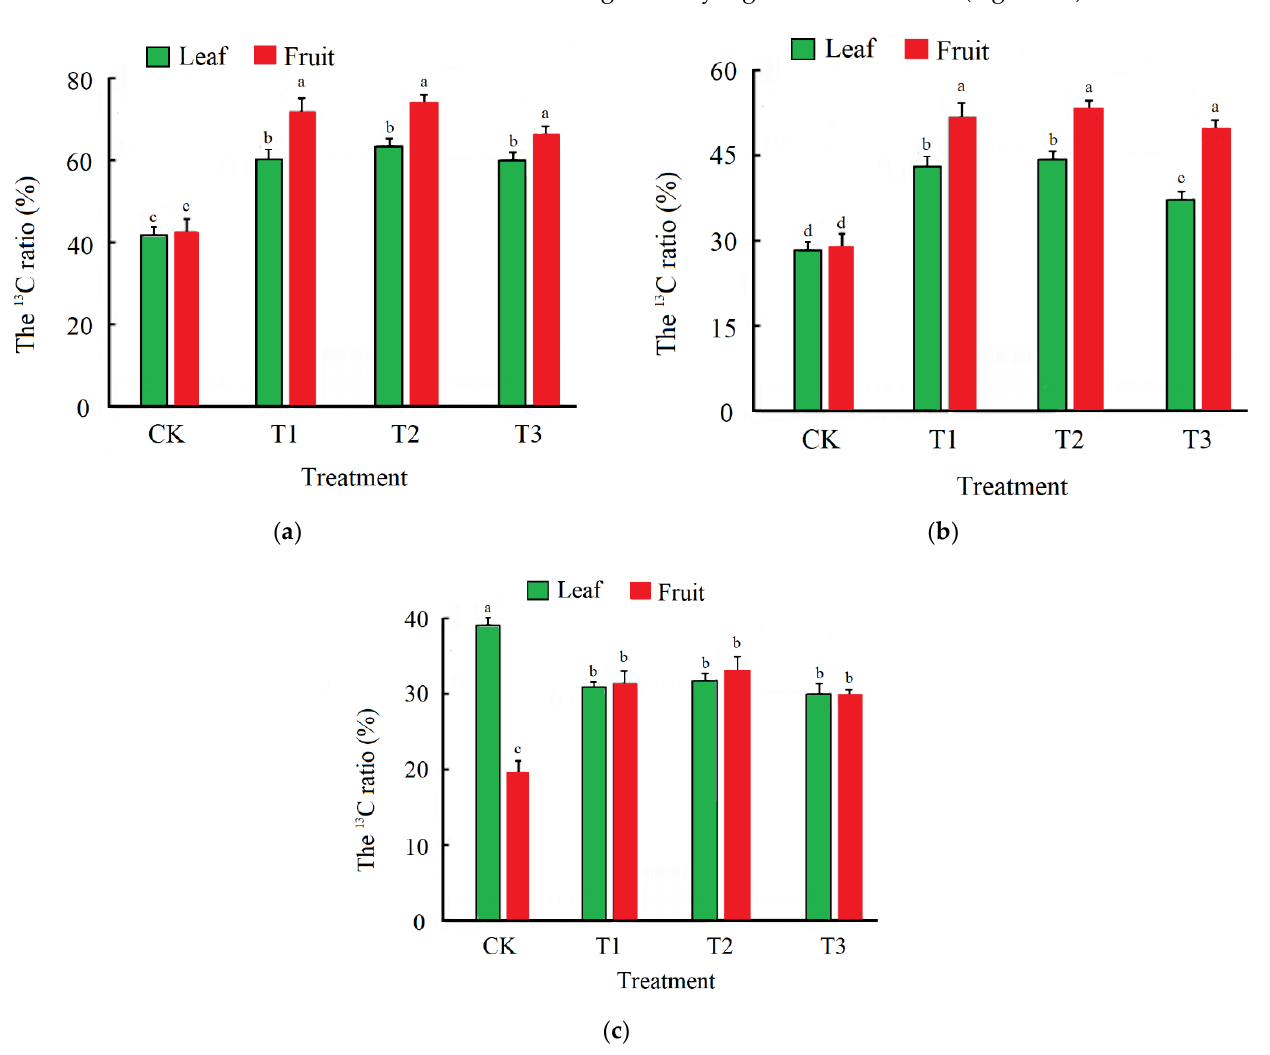
Figure 3. Distribution patterns of exported 13 C in fruit fixed by different source leaves. ( a ) The 1st leaf as 13 C source leaf, ( b ) the 2nd leaf as 13 C source leaf, and ( c ) the 3rd leaf as 13 C source leaf. 13 CO 2 was applied to leaves for 3 h and left to sit for 48 h; the effect of photosynthetic products on fruit development was determined by a stable isotope ratio mass spectrometer. Tukey’s HSD test was used, and vertical bars represent standard errors of the means ( n = 15). Different letters indicate significant differences at p < 0.05, according to Tukey’s HSD test.